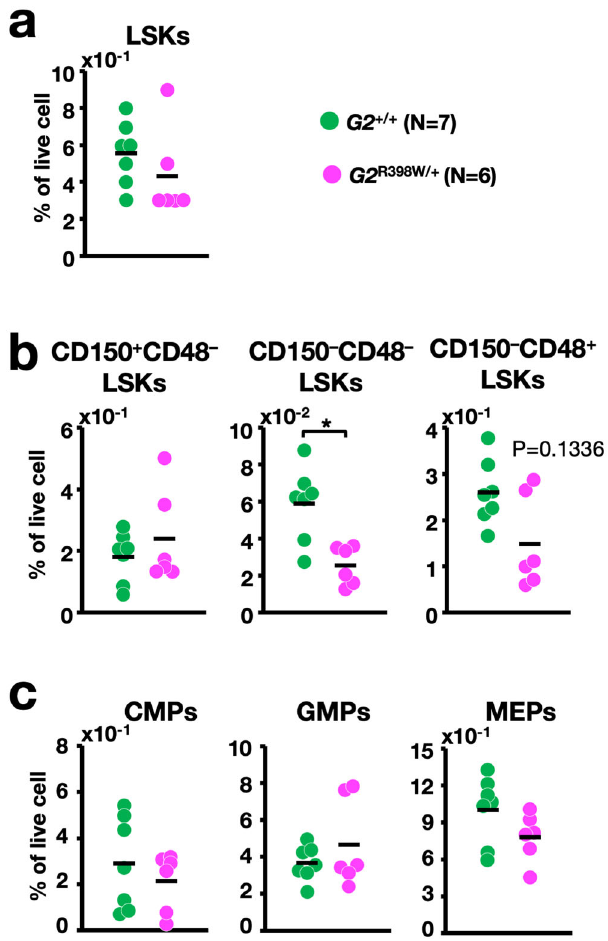
Fig. 4 Born marrow stem and progenitor cell populations in 12-month-old G2 R398W/ + mice. a Quanti fi cation of LSKs in the bone marrow of G2 + / + and G2 R398W/ + mice. b , c Quanti fi cation of stem cell populations subdivided according to CD150 and CD48 pro fi les ( b ) and progenitor populations ( c ) in the bone marrow of G2 + / + and G2 R398W/ + mice. * p < 0.05. N = 10 of each